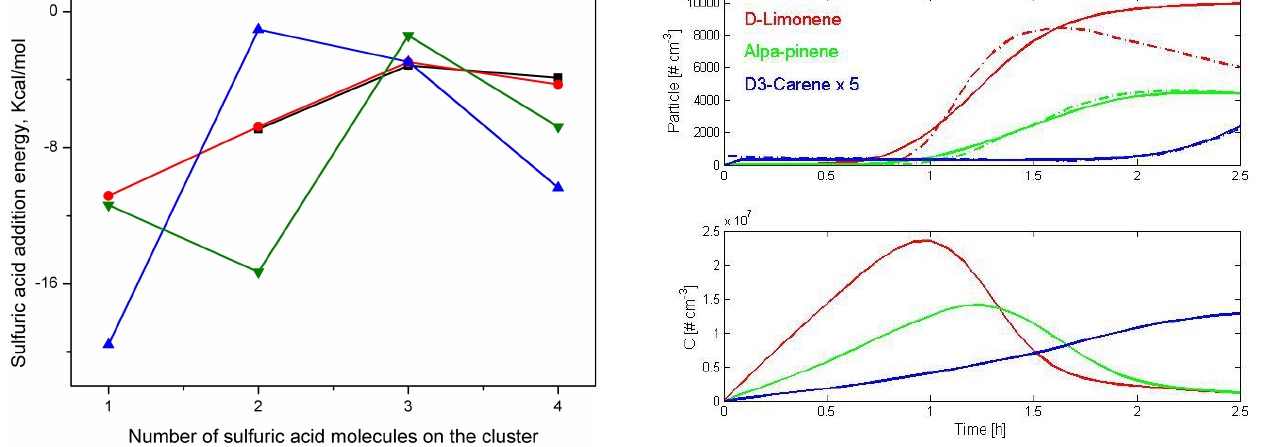
Fig. 8. Addition energy of sulphuric acid versus number of sul- phuric acid molecules in the cluster. Black line: pure sulphuric acid clusters, Red line: clusters containing one molecule of limononic acid, Blue line: clusters containing one molecule of OH-caronic acid, Green line: clusters containing one molecule of OH-pinonic acid.